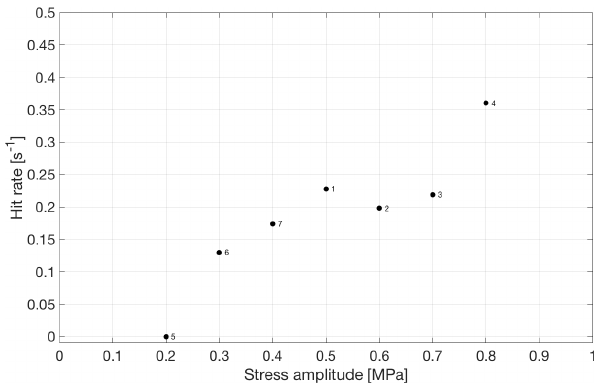
Figure 13. Hit rate as a function of cycled stress amplitude for saline ice sample of lower salinity (3.0 ± 0.9ppt). Numbers show the order of cycling at different stress